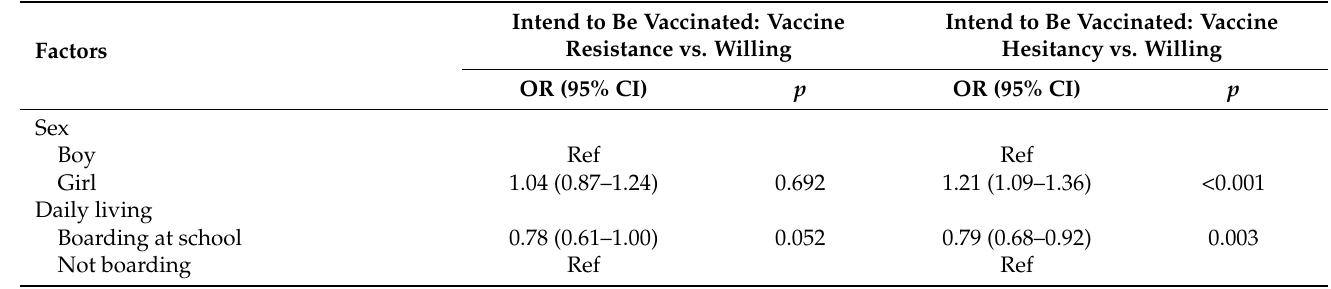
Table 3. Factors associated with the willingness of receiving a COVID-19 vaccine among school students in grades 7–12 in four cities in China—multinomial logistic